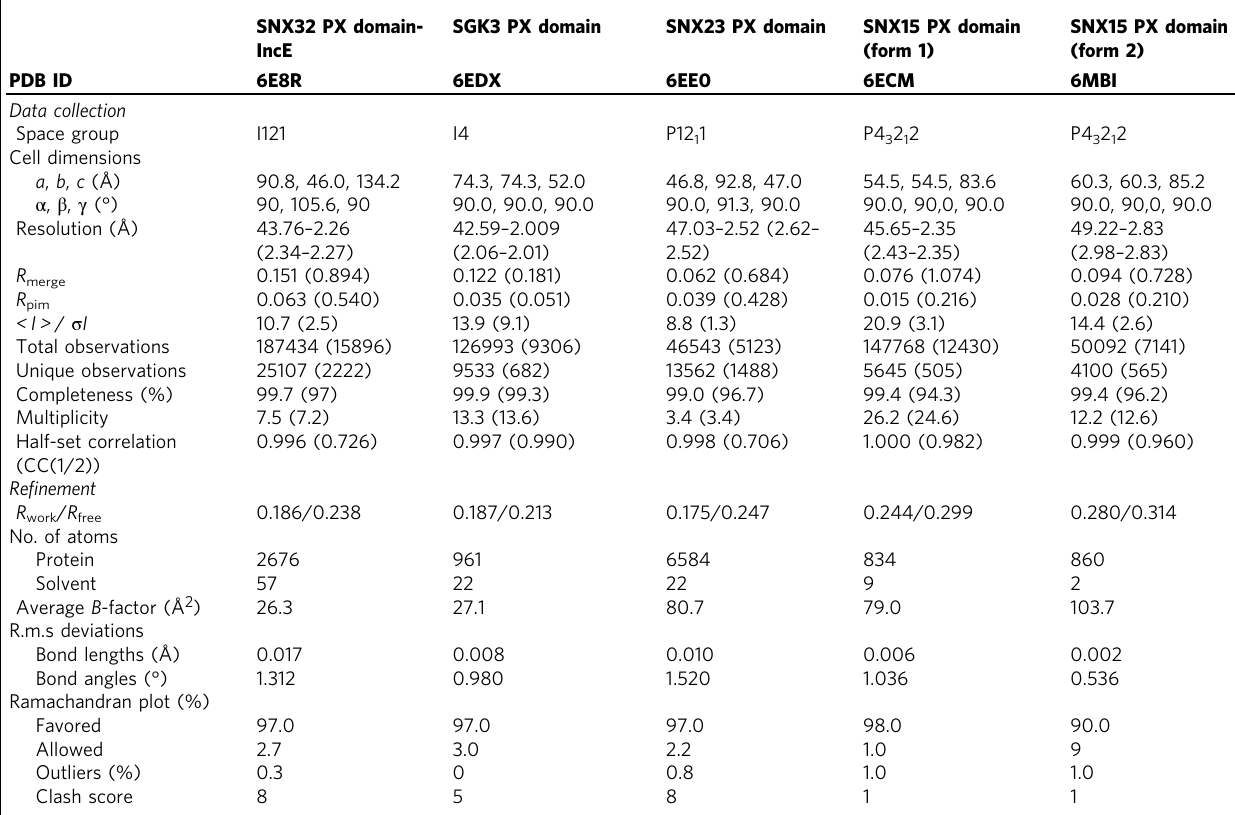
Table 1 Summary of crystallographic structure determination